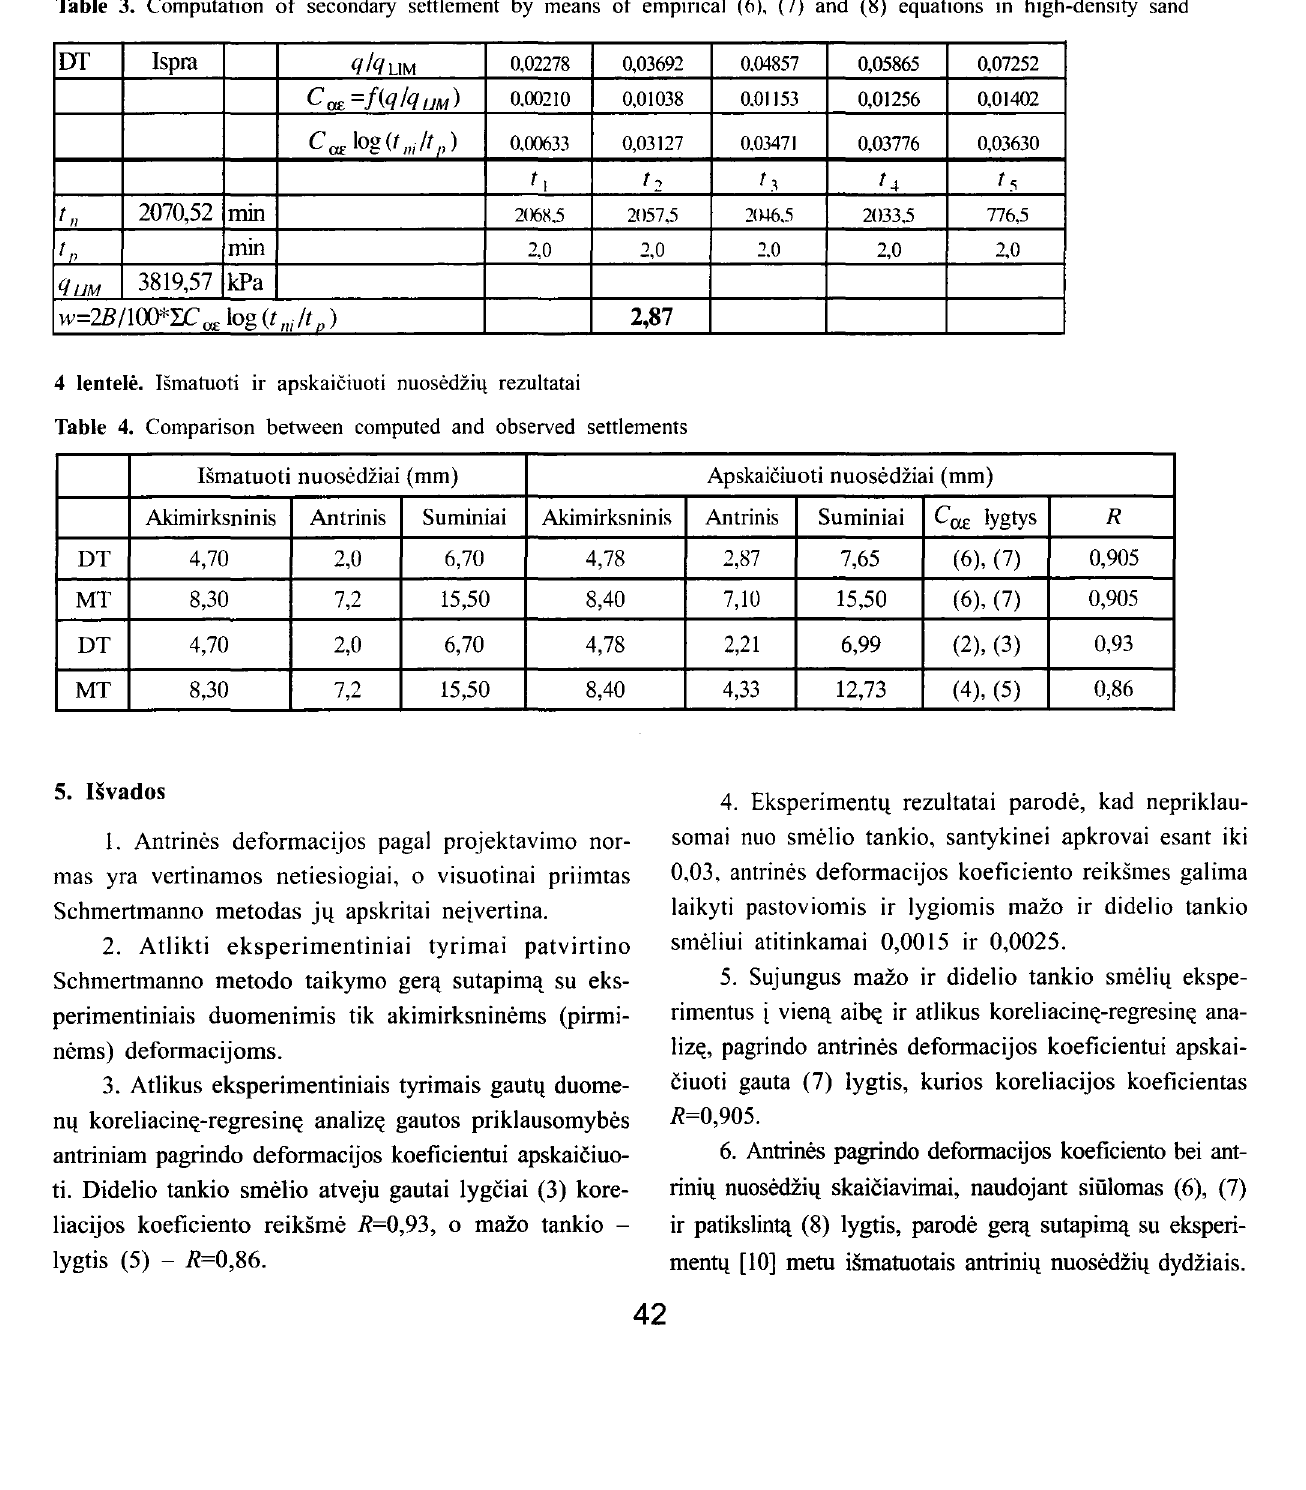
Table 3. Computation of secondary settlement by means of empirical (6), (7) and (8) equations in high-density sand